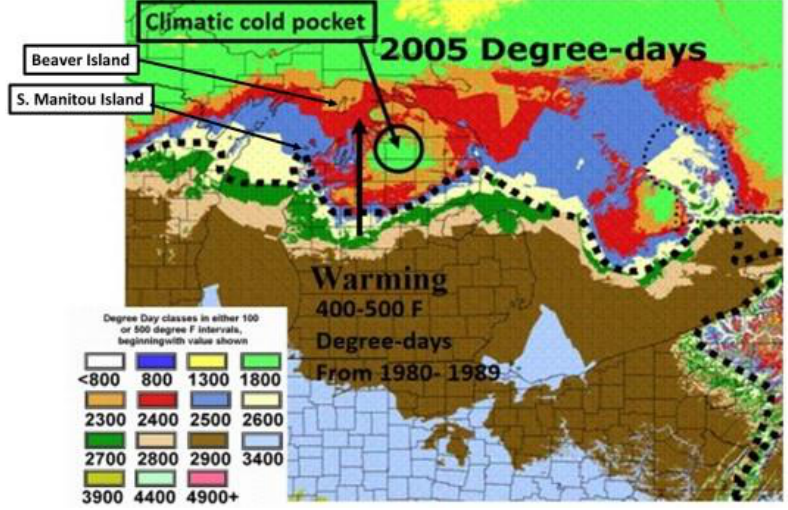
Figure 4. Enlargement of the thermal landscape in a warm Michigan summer (2005), showing D-days that are 500 (cid:177) 600 °F, or more, greater than the 1980 (cid:177) 1989 mean shown in (cid:41)(cid:76)(cid:74)(cid:88)(cid:85)(cid:72)(cid:3)(cid:22)(cid:17)(cid:3)(cid:49)(cid:82)(cid:81)(cid:72)(cid:87)(cid:75)(cid:72)(cid:79)(cid:72)(cid:86)(cid:86)(cid:15)(cid:3)(cid:87)(cid:75)(cid:72)(cid:3)(cid:179)(cid:70)(cid:82)(cid:79)(cid:71)(cid:3)(cid:83)(cid:82)(cid:70)(cid:78)(cid:72)(cid:87)(cid:180)(cid:3)(cid:76)(cid:86)(cid:3)(cid:86)(cid:87)(cid:76)(cid:79)(cid:79)(cid:3)(cid:72)(cid:89)(cid:76)(cid:71)(cid:72)(cid:81)(cid:87)(cid:3)(cid:85)(cid:72)(cid:79)(cid:68)(cid:87)(cid:76)(cid:89)(cid:72)(cid:3)(cid:87)(cid:82)(cid:3)(cid:87)(cid:75)(cid:72)(cid:3)(cid:86)(cid:88)(cid:85)(cid:85)(cid:82)(cid:88)(cid:81)(cid:71)(cid:76)(cid:81)(cid:74)(cid:3) counties. The cold pocket has actually shown greater relative warming than these surrounding areas over the recent 2 decades (see Figure 7). Note that South Manitou Island in northern Lake in Lake Superior), and introgressive traits from P . glaucus have been seen here (see text). The Degree-day values of color codes (Celsius) are shown in Figure 3 for